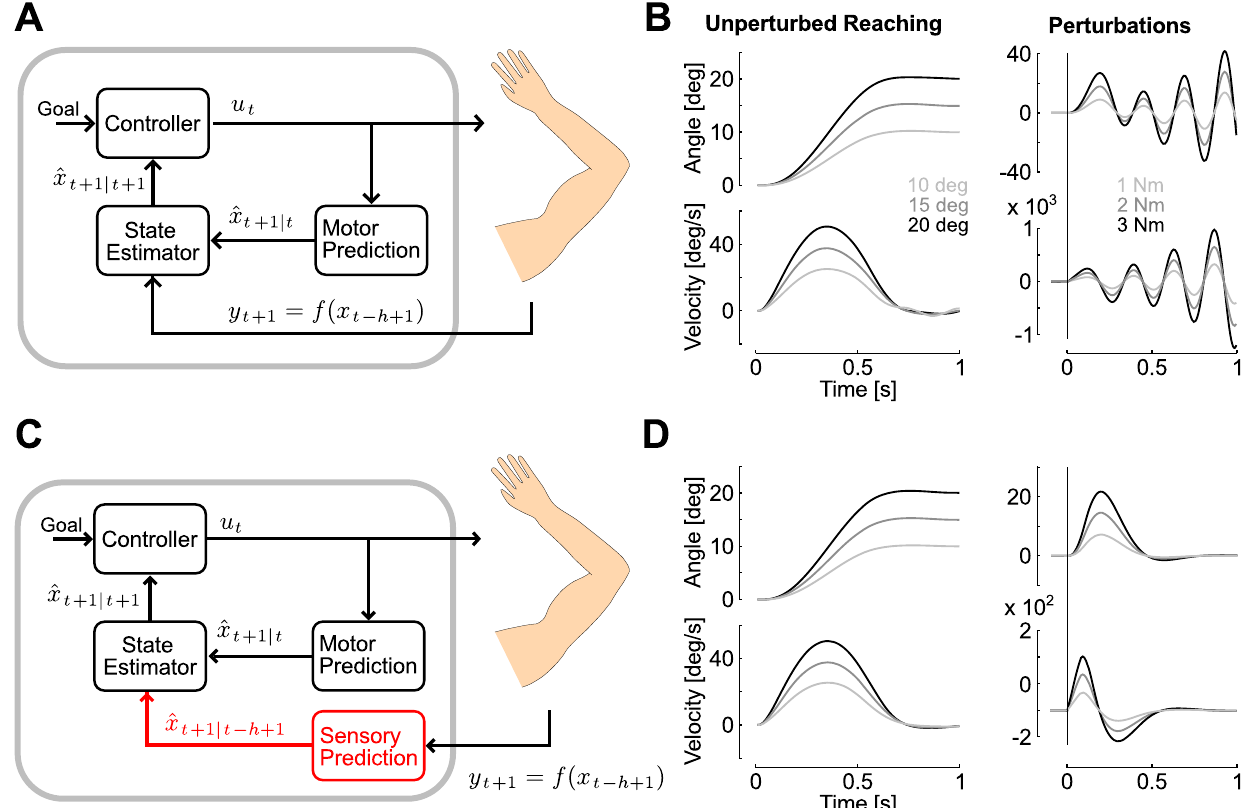
Figure 2. Computational models and simulations. A: Computational model based on a state estimator that ignores feedback delays and directly integrates sensory feedback with prior beliefs about the body state. The controller outputs a motor command ( u t ) specified by the behavioral goal and motor costs. The forward dynamic model (Motor Prediction) predicts the consequence of the descending motor command (Predicted Consequences, ^ xx t z 1 D t ). The feedback signal ( y t + 1 ) is a function of the delayed state vector expressed in f(x t 2 h + 1 ) , where h represents the feedback delay in number of sample times (see Methods). B: Simulation of the model corresponding to panel A on the control of a single joint actuator during unperturbed reaching movements of varying amplitudes (left) and following perturbation loads of three selected magnitudes (right). Displays are the joint angle (top) and angular velocity (bottom). Time 0 corresponds to the onset of the reaching movement, or the perturbation onset (solid line). C: Full model with the sensory predictor highlighted in red. Following a perturbation, the output of the motor prediction still indicates that the joint displacement is zero, but the sensory prediction corrects the estimate of the joint state based on maximum-likelihood principle. This is illustrated by the conditional expectation about the present state, given delayed sensory information (Predicted Current State, ^ xx t z 1 D t { h z 1 ) D: Same as B with the control and state estimation corresponding to panel C.